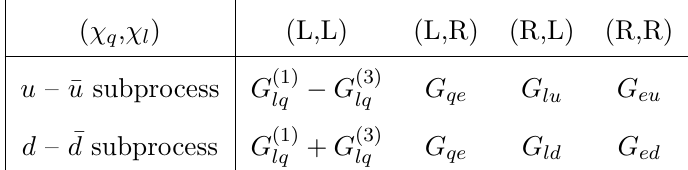
defined in eq. (B.2) for the q χq ,l χl